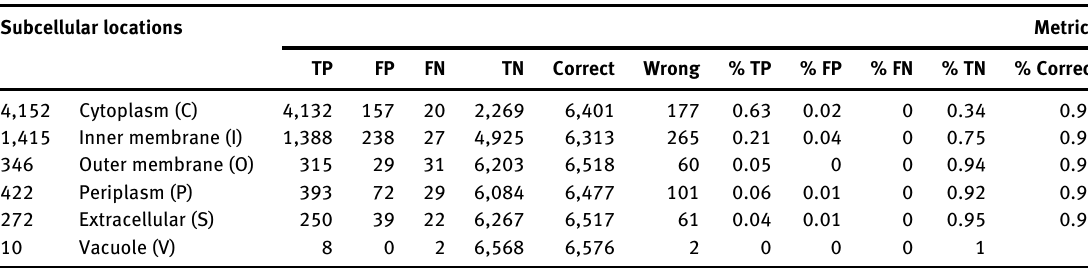
Table  : Performanceevaluation by  -fold cross-validation tests onGram-negative bacteriaproteinsusinga consensus of PSSM and GO terms-based predictions. The multi-label confusion matrix re fl ects well the predictions performance for each location separetely.